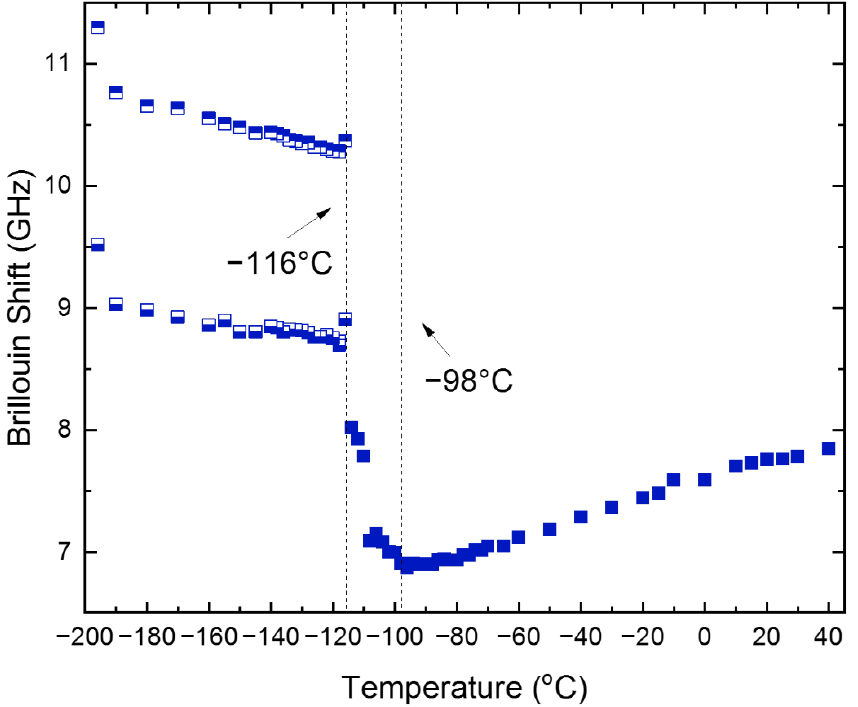
Figure 4. (Color online). Temperature dependences of the Brillouin frequency shift of the TA mode propagating along the [100] direction, measured upon cooling. The two symbols at low temperatures indicate the data from the split TA mode.